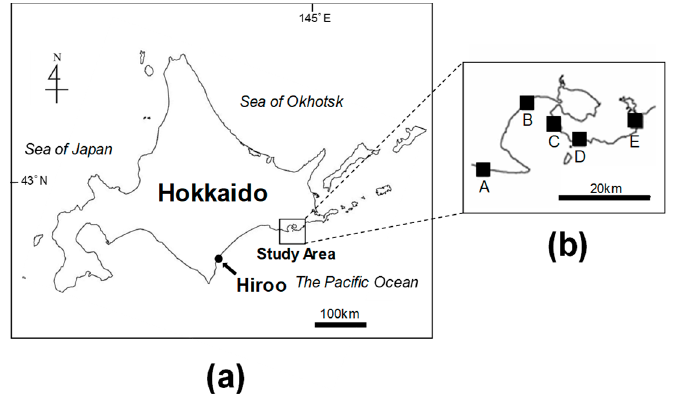
Figure 1. ( a ) The study area on Hokkaido, Japan. Hiroo was the eastern front of the area invaded by Balanus glandula in 2000 [10]. ( b ) Map showing the studied